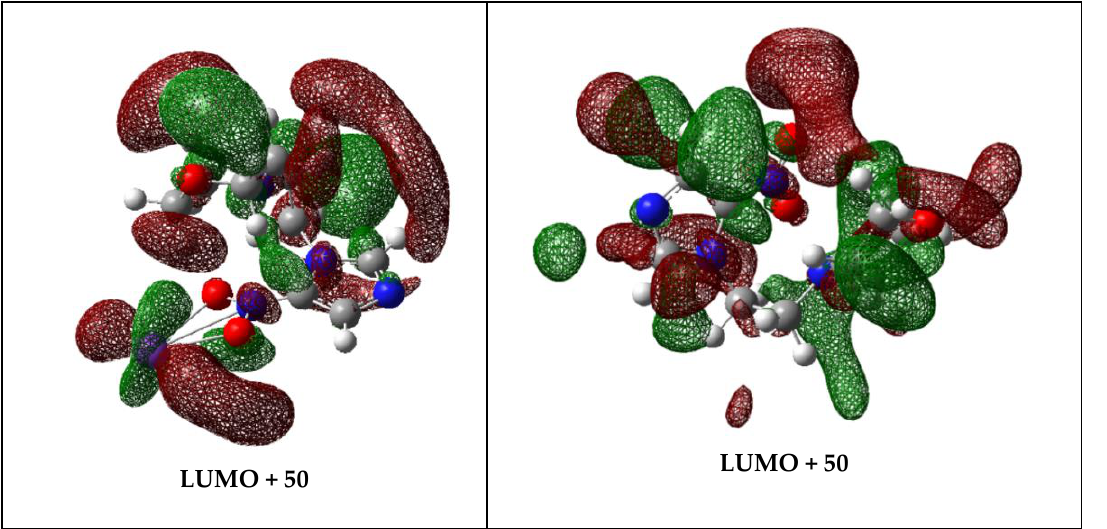
Figure 6. Calculated highest occupied molecular orbitals (HOMO-1 and HOMO) and lowest unoccupied molecular orbital (LUMO + 50) for K + NIMO and NIMO (K: purple, C: grey, N: blue, O: red, and H: white). The straight lines between the K atom and the – NO 2 end in the 4-nitroimidazole ring are just to indicate the spatial mutual position. For a complete set of MOs see Figures S2 and S3.